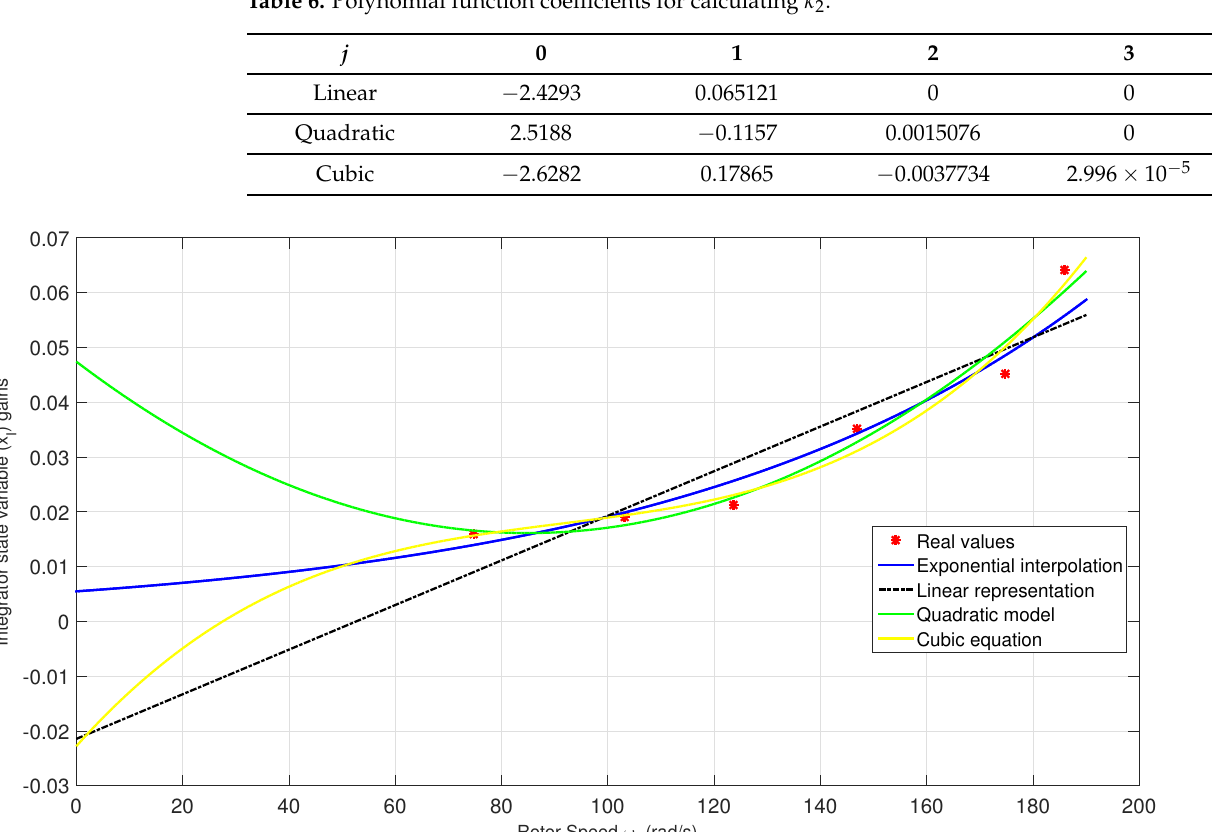
Table 6. Polynomial function coefficients for calculating k 2 .